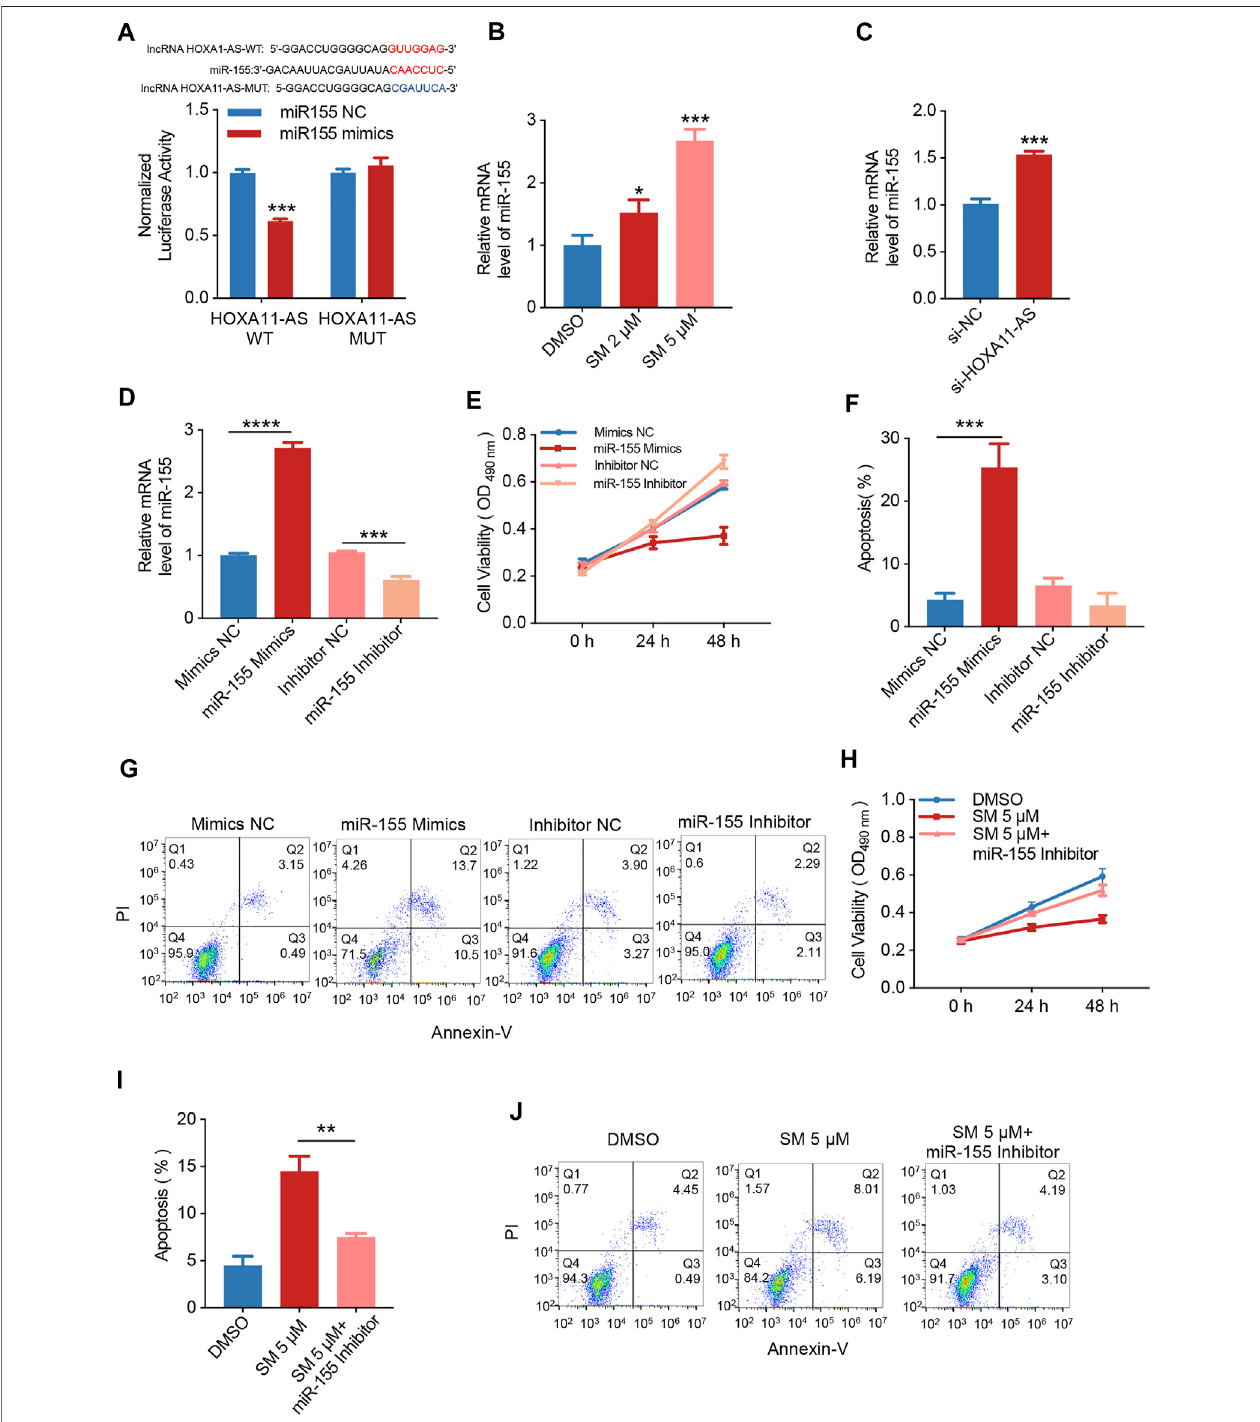
FIGURE 4 | SM regulates miR-155 -induced apoptosis by reducing lncRNA HOXA1-AS expression. (A) Relative luciferase activity of 293 cells co-transfected with miR-155 NCor miR-155 mimicsandthewild-typeormutatedlncRNA HOXA11-AS . (B) Relativeexpressionof miR-155 wasanalyzedbyRT-PCRafterDMSOand2and 5 μ M SM treatment in FaDU cells. (C) Relative expression of miR-155 analyzed by RT-PCR transfected with si-NC or si-HOXA11-AS in FaDU cells. (D) Relative expression of miR-155 in FaDU cells was analyzed by RT-PCR after being transfected with the miR-155 mimic and inhibitor. (E) Cell viability of FaDU cells transfectedwiththe miR-15 5mimicandinhibitorwasanalyzedbyMTTassayat0,24,and48 h( n =5). (F,G) ApoptosisofFaDUcellstransfectedwiththe miR-155 mimic and inhibitor was analyzed by fl ow cytometry, and the total apoptotic percentage was calculated using FlowJo software. (H) Cell viability of FaDU cells transfected with the miR-155 inhibitorandtreatedwith5 μ MSMwasanalyzedbyMTTassayat0,24,and48 h( n =5). (I,J) ApoptosisofFaDUcellstransfectedwiththe miR-155 inhibitor and treated with 5 μ M SM was analyzed using fl ow cytometry, and the total apoptosis proportion was calculated by FlowJo software. *( p < 0.05), **( p < 0.01), ***( p < 0.001), and ****( p < 0.0001) indicate statistically signi fi cant differences.